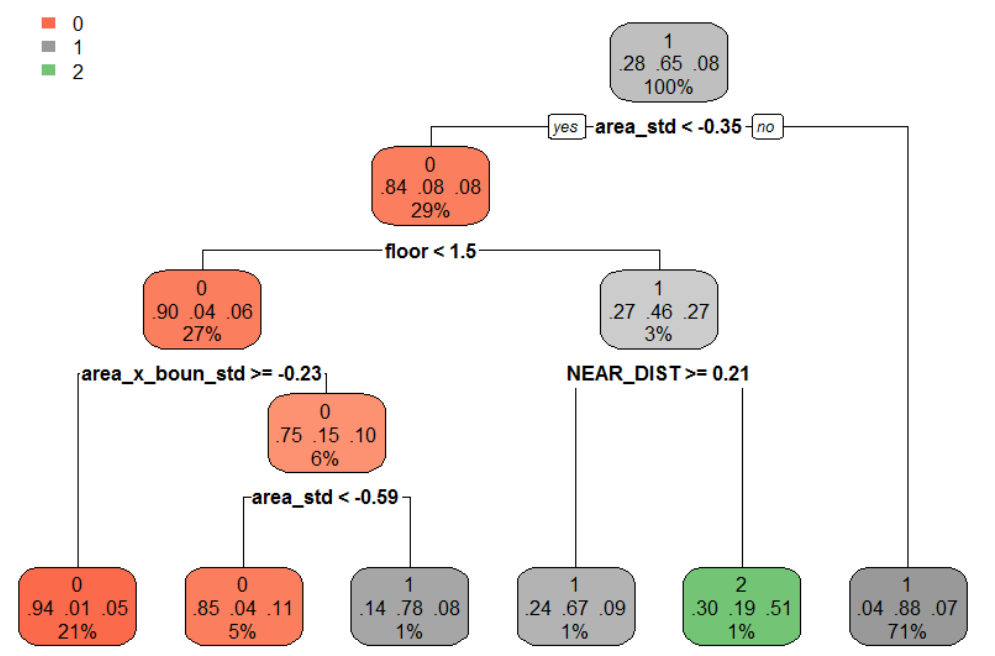
Figure 6. Decision tree of building classification.